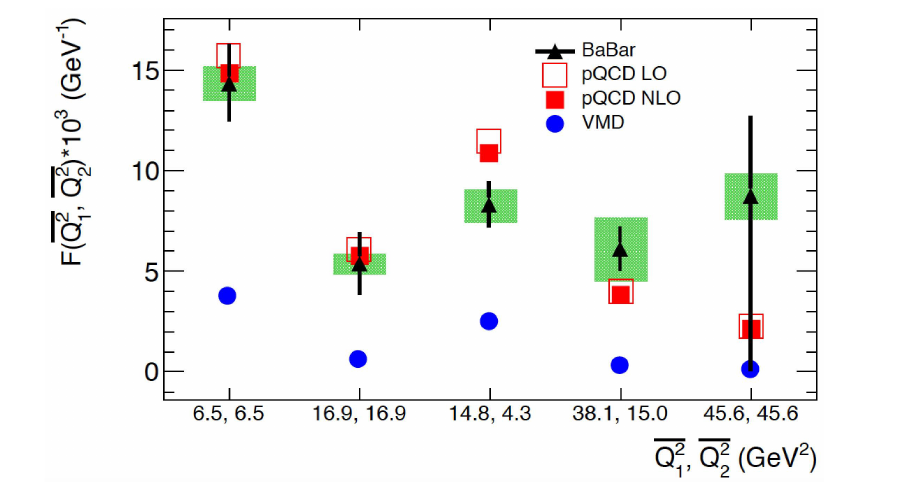
Figure 6. The measured γ ∗ γ ∗ → η (cid:48) transition form factor (triangles) in the five intervals of ( Q 2 in comparison with the predictions of pQCD at leading- (open squares) and next-to-leading- (filled squares) order and with the predictions of the vector meson dominance model. The error bars on the data points are statistical. The (green) rectangular shaded areas show the systematic uncertainties.